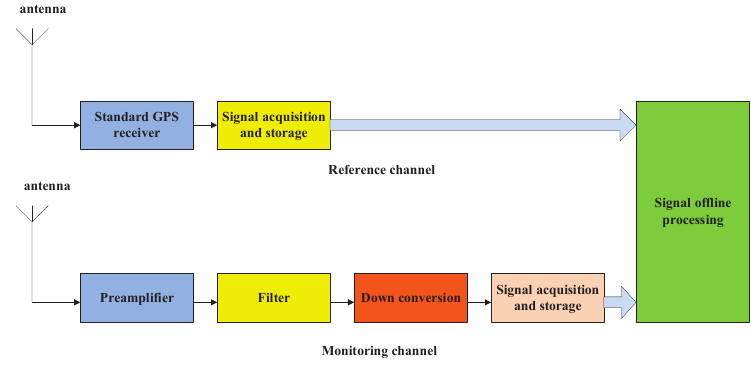
Figure 2. The diagram of the receiving signal